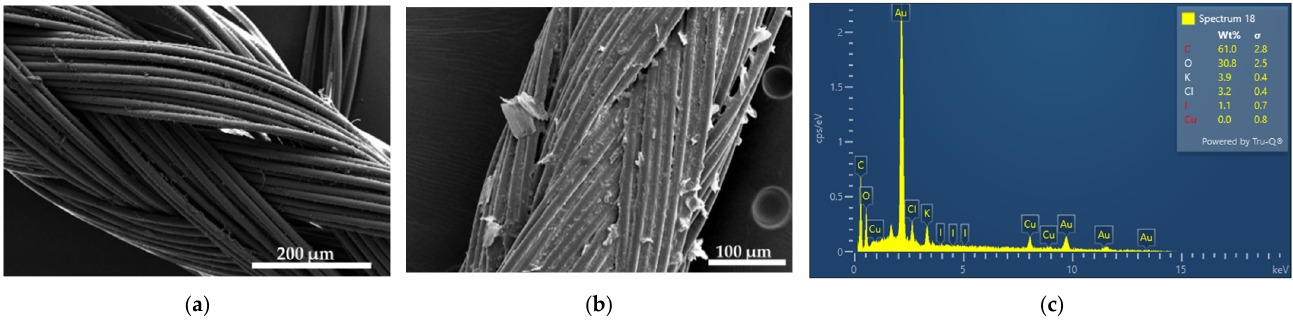
Figure 2. SEM of sutures: ( a ) plain suture [31]; ( b ) impregnated with AV-PVP-TCA-I 2 ; ( c ) EDS of coated sutures.